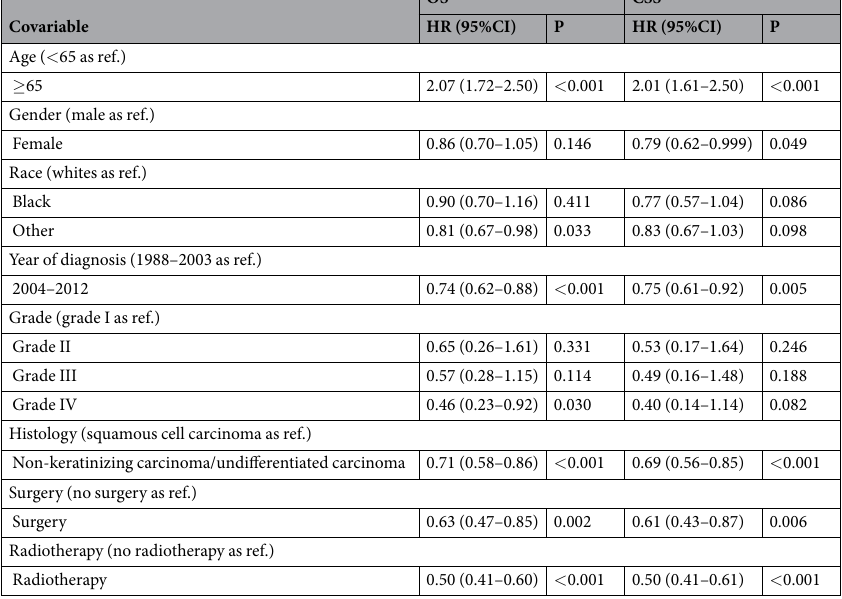
Table 2. Univariate analyses of OS and CSS.